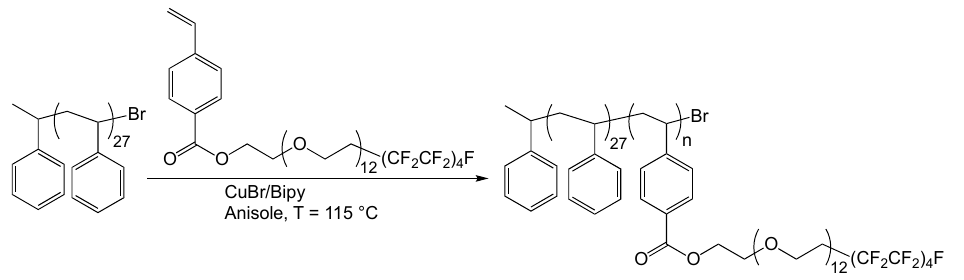
Figure 1. Schematic of the atom transfer radical polymerization (ATRP) synthesis of the diblock copolymers S27SzAn by macroinitiator S27.